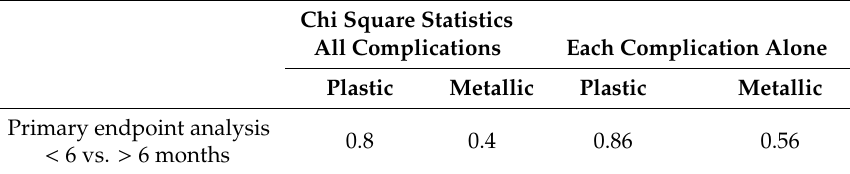
Table 5. Chi square statistics according to biliary stent